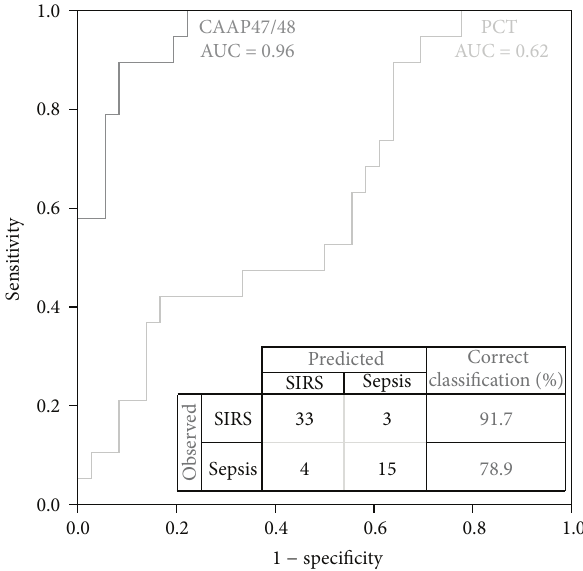
Figure 7: Receiver operating characteristic (ROC)-curve analysis comparing the test-characteristics of CAAP47/48 and procalcitonin (PCT) for discrimination of patients with severe sepsis ( 𝑛 = 19 ) and patients with severe SIRS (polytrauma and cardiac surgery, 𝑛 = 36 ). The area under the ROC-curve (AUROC) for CAAP47/48 (0.96) is significantly higher than for PCT (0.62) demonstrating a greater diagnostic accuracy of CAAP47/48 compared to PCT. The optimal cutoff, which is defined to be the concentration at which patients are classified into the SIRS or sepsis group with highest sensitivity and specificity, is 4.9 𝜇 M. Severe SIRS and severe sepsis patients can be differentiated with 91.7% specificity and 78.9%